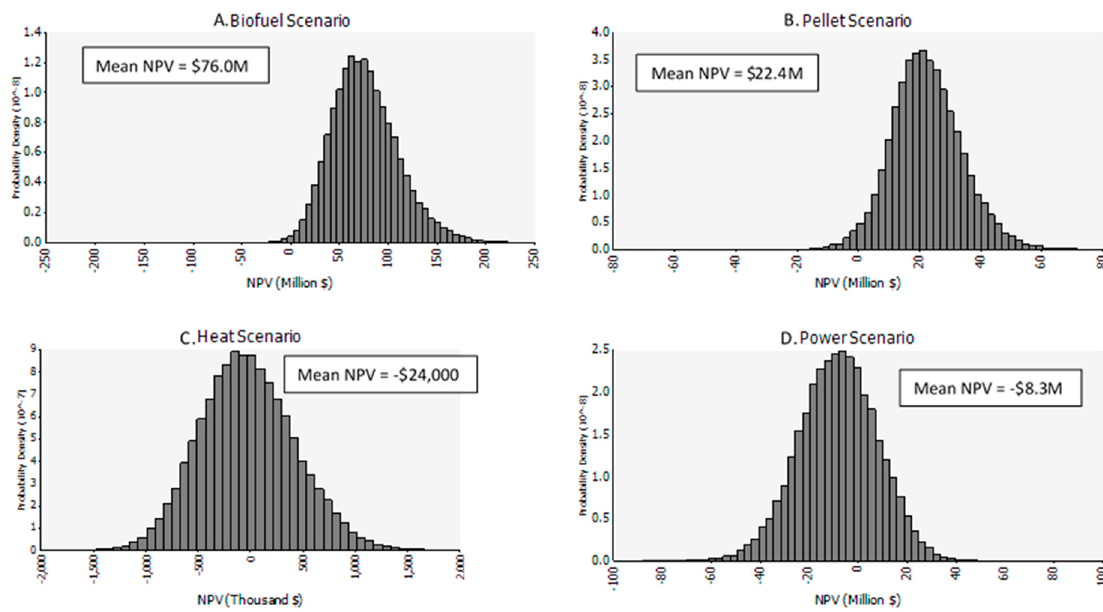
Figure 6. Histograms of Net Present Value (NPV) Distributions from Simulations of 50,000 Iterations, by Scenario. ( A ) Biofuel Scenario: 99% positive outcomes. Range from − $21.6 million to $246.3 million. ( B ) Pellet Scenario: 98% positive outcomes. Range from − $19.2 million to $76.2 million. ( C ) Heat Scenario: 46% positive outcomes. Range from − $1.7 million to $1.9 million. ( D ) Power Scenario: 30% positive outcomes. Range from − $74.5 million to $51.4 million.